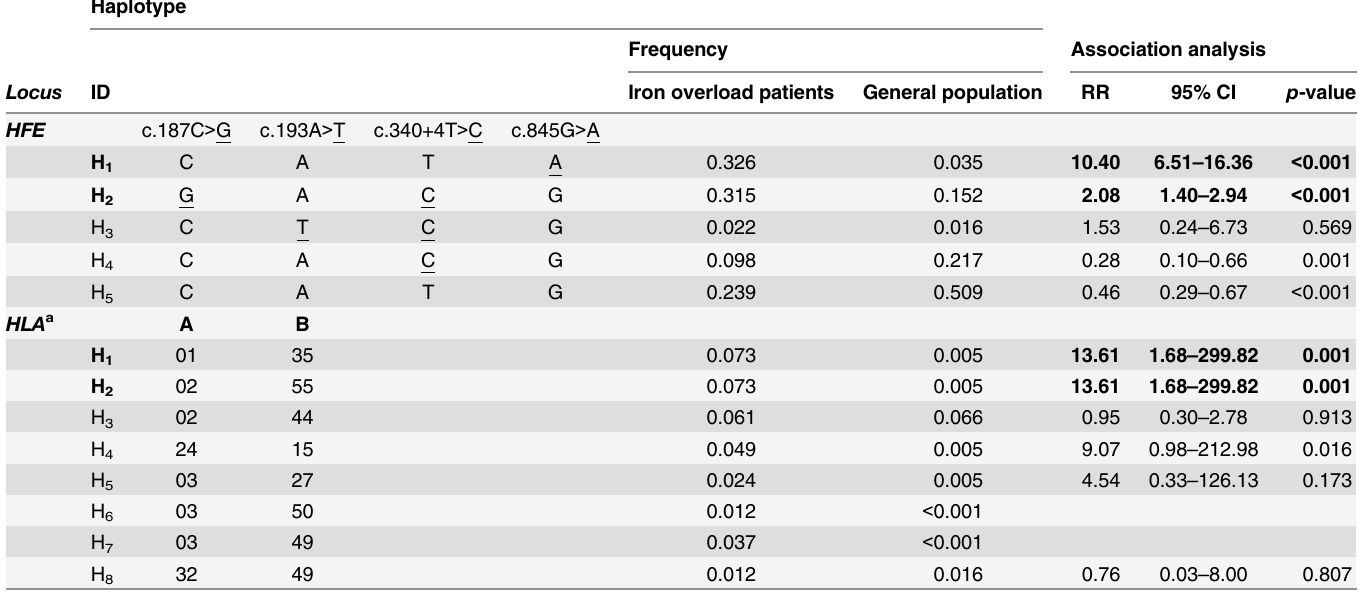
Table 2. HFE and HLA haplotype frequency and association analysis with iron overload. HFE haplotypes were indirectly inferred by Arlequin, whereas HLA haplotypes were directly inferred by homozygosity.